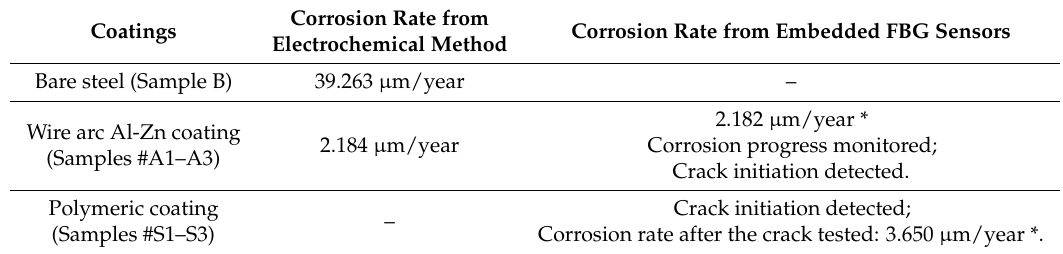
Table 7. Comparison of corrosion test results between electrochemical approach and FBG